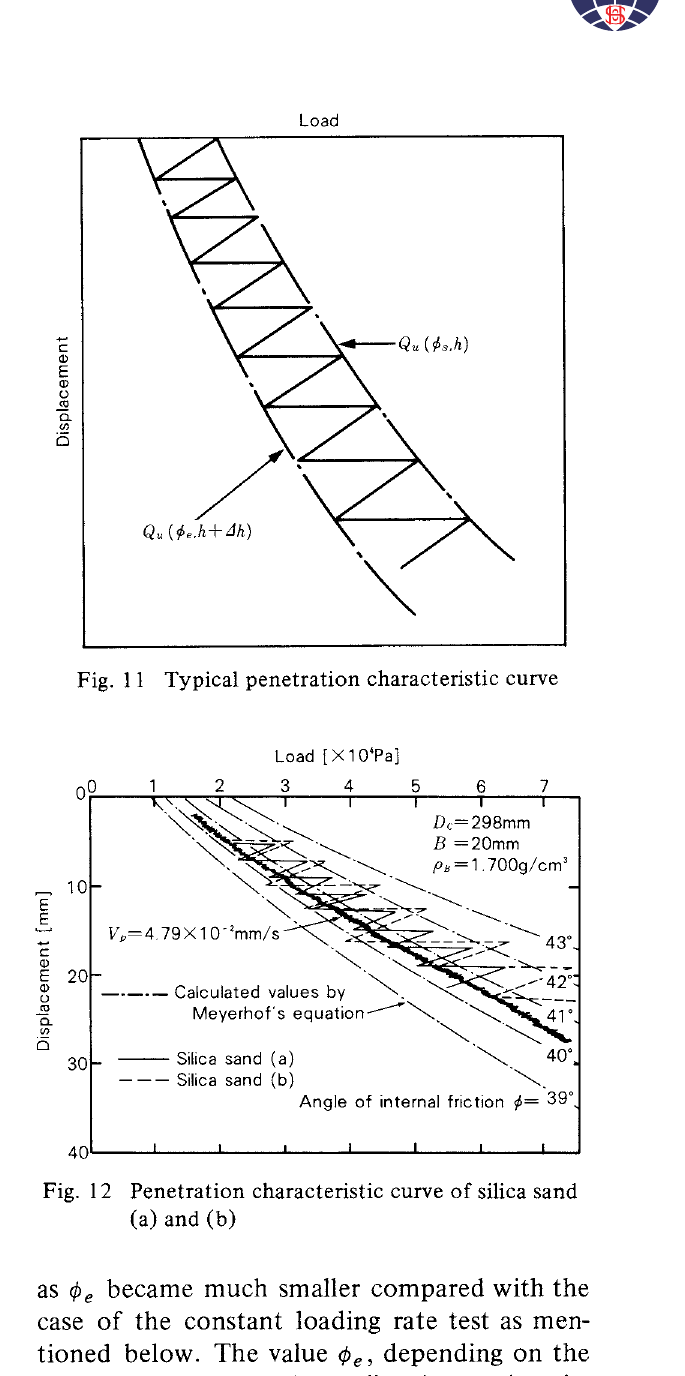
Fig. 12 Penetration characteristic curve of silica sand (a) and